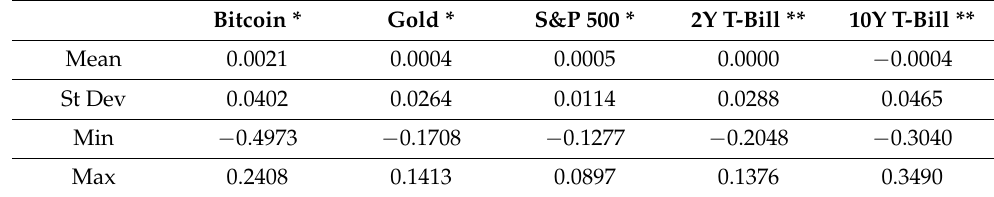
Table 2. Summary statistics of the 5